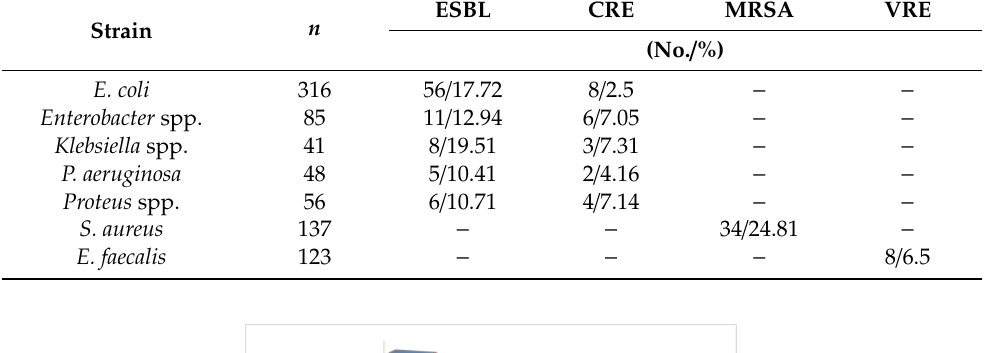
Table 6. The frequency of strains with different phenotypes of resistance.